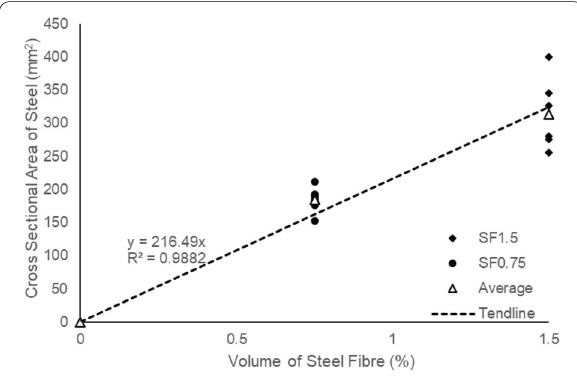
Fig. 6 Cross-sectional area of steel